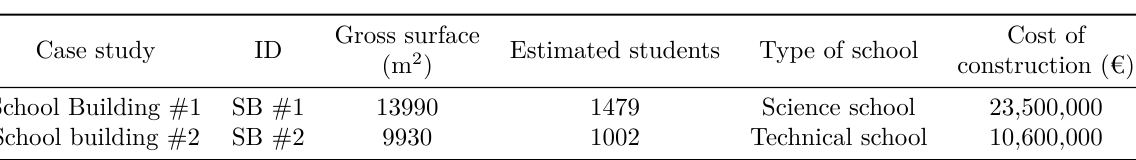
Table 1. Main properties of the two